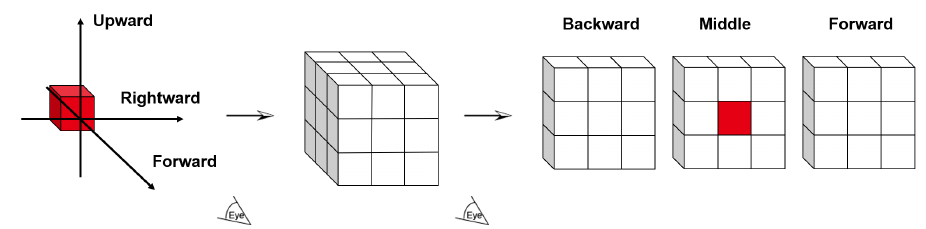
Figure 3. Take a single voxel as the origin of the coordinate system and extend it to a space of 3 × 3 × 3 voxel. The 3 × 3 × 3 voxel space is divided into three layers based on the distance from the eye. Table 1. The twenty-six directions map.